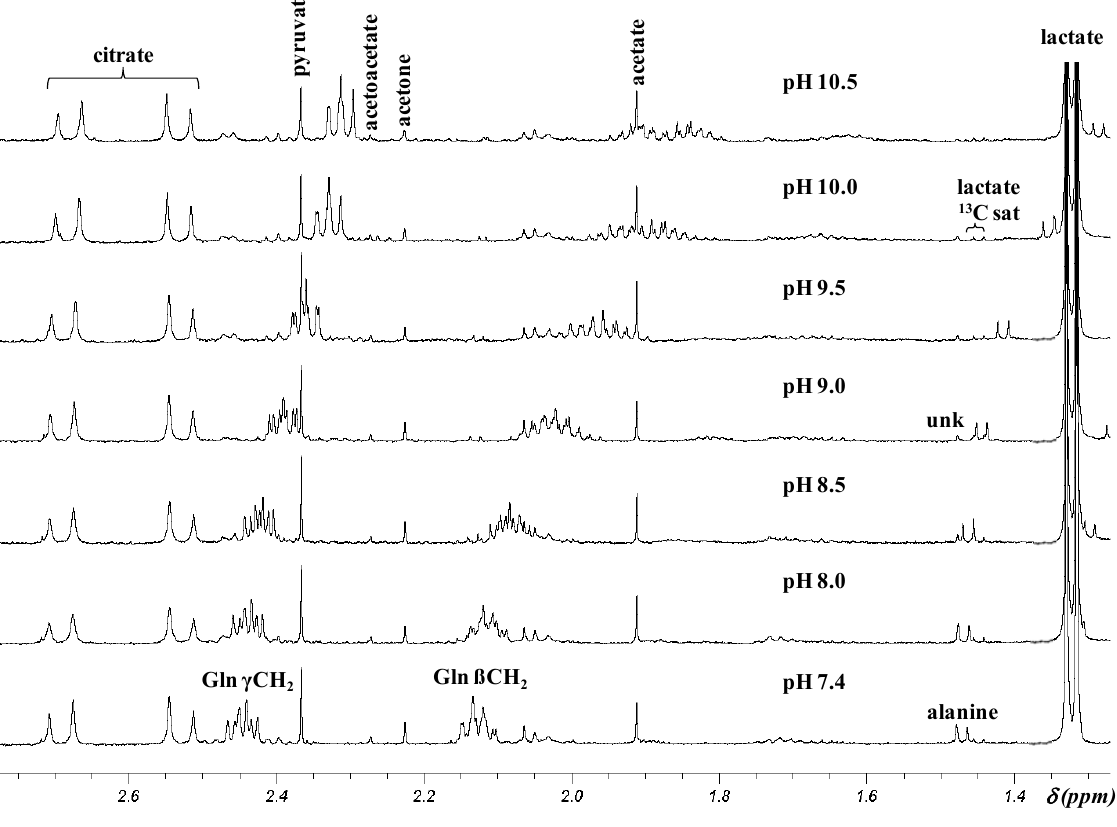
Figure 4. Representative 1 H NMR spectra (1.25–2.8 ppm region) of a CSF sample O whose pH was adjusted at different pH between 7.4 and 10.5. Gln: containing 33% D 2 glutamine; sat: satellite; unk: